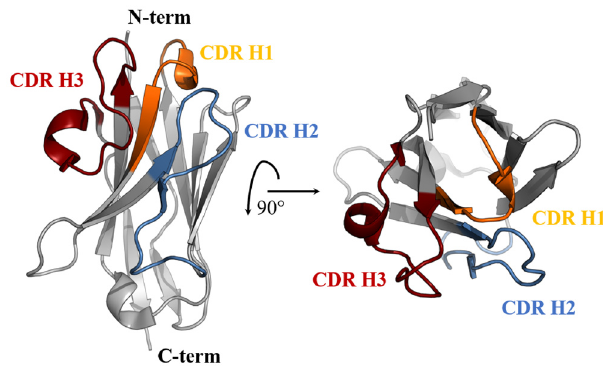
Figure 3. Ribbon diagram of the crystal structure of BCD090-M2 in space group C2 at 1.6 Å resolution (PDB:6EZW). Framework regions are grey and CDRs are colored.